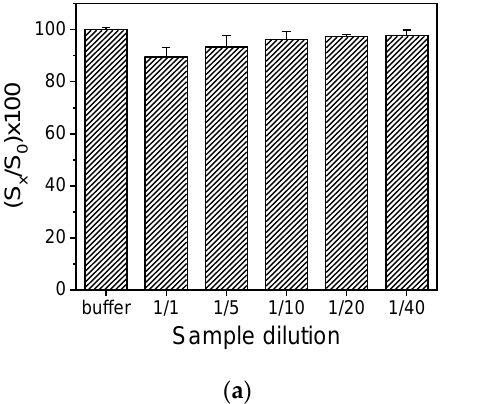
Figure 7. ( a ) Effect of maize water extract dilution with assay buffer to zero calibrator signal values Figure 7. ( a ) E ff ect of maize water extract dilution with assay bu ff er to zero calibrator signal values with respect to zero calibrator value in buffer. ( b ) DON calibration curves received with calibrators with respect to zero calibrator value in bu ff er. ( b ) DON calibration curves received with calibrators prepared in assay buffer (black squares) or in maize water extract diluted ten times with assay buffer prepared in assay bu ff er (black squares) or in maize water extract diluted ten times with assay bu ff er (red squares). Each point is the mean value of 3 measurements ± SD. (red squares). Each point is the mean value of 3 measurements ±